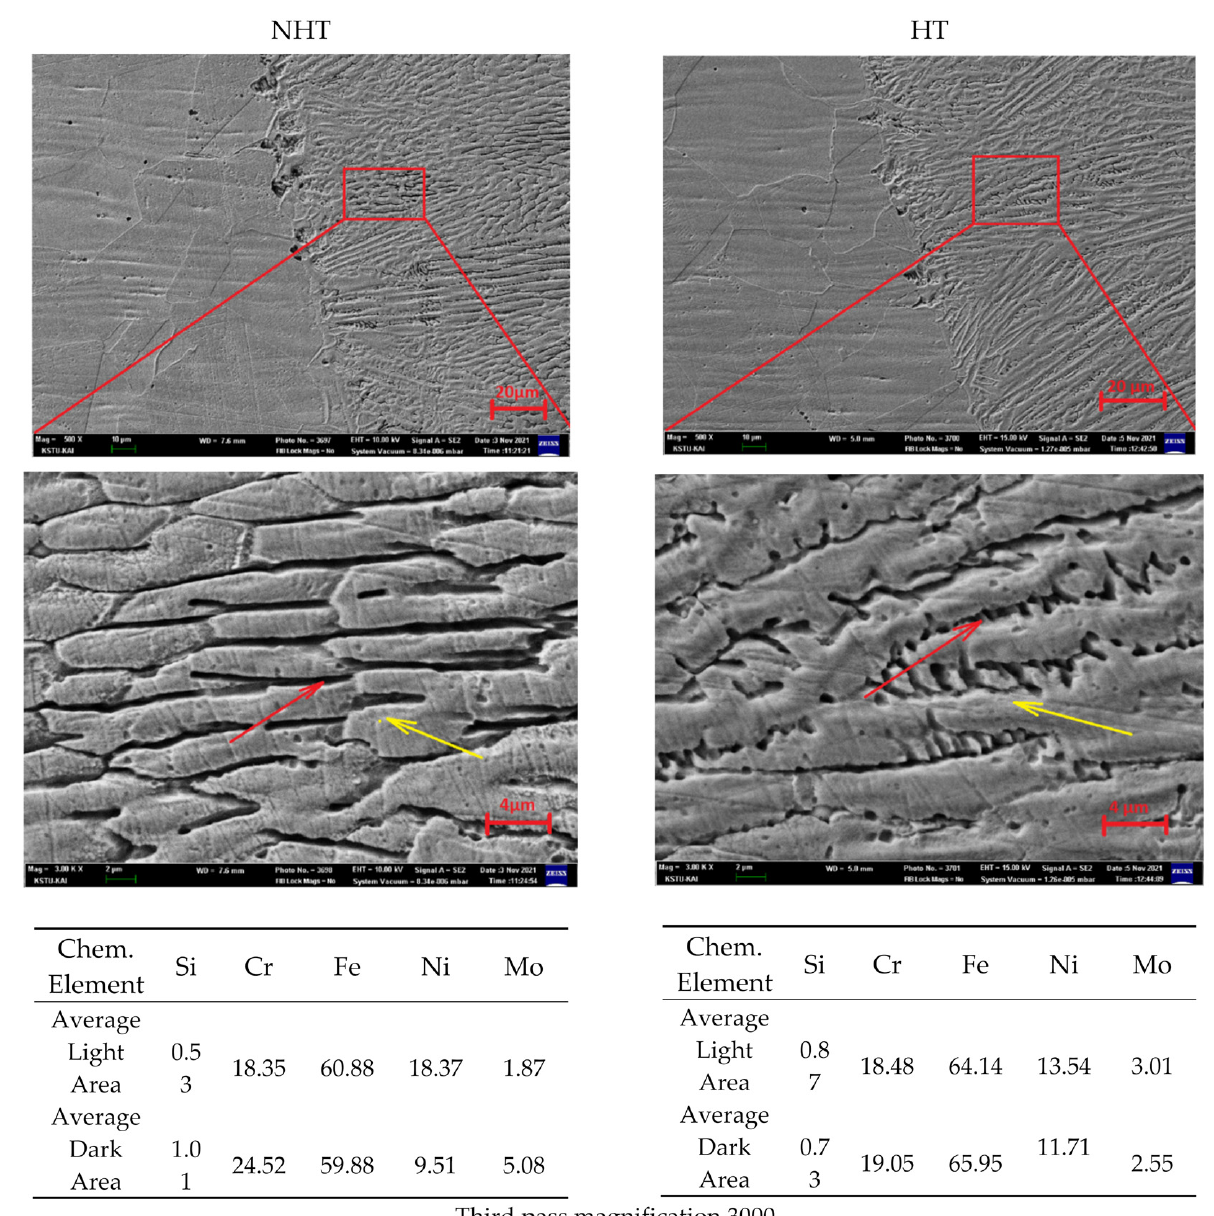
Figure 14. Microstructure and distribution of chemical elements of the upper part of the third pass (left NHT, right HT, magnification 500 and